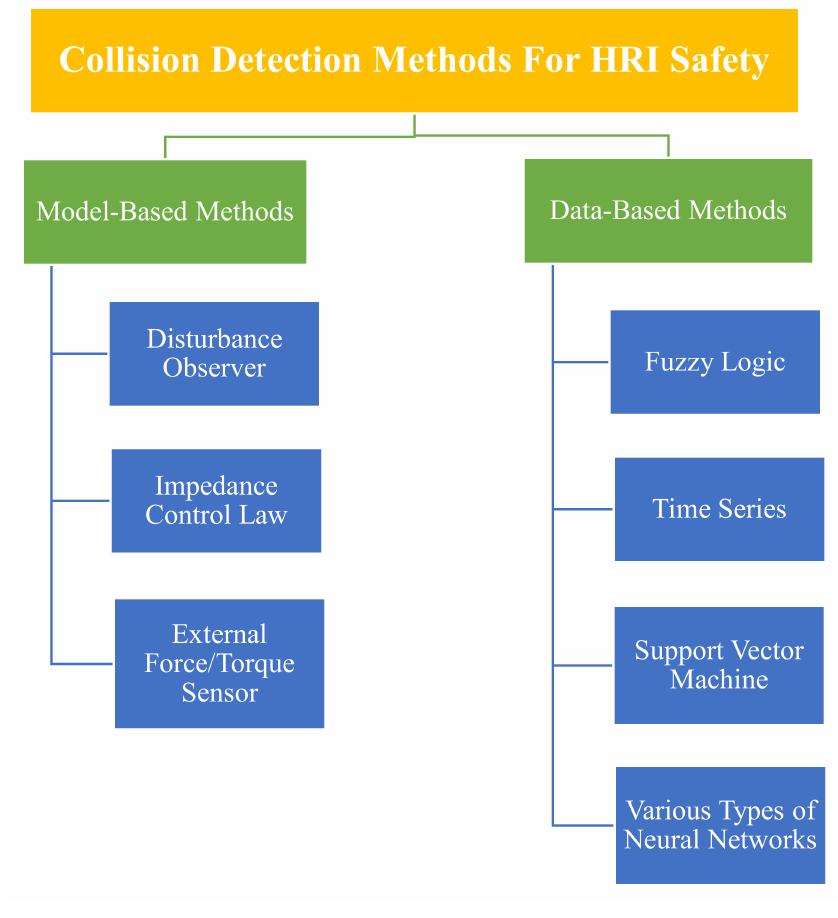
Figure 9. The classifications of the collision detection techniques used for the safety of HRI’s